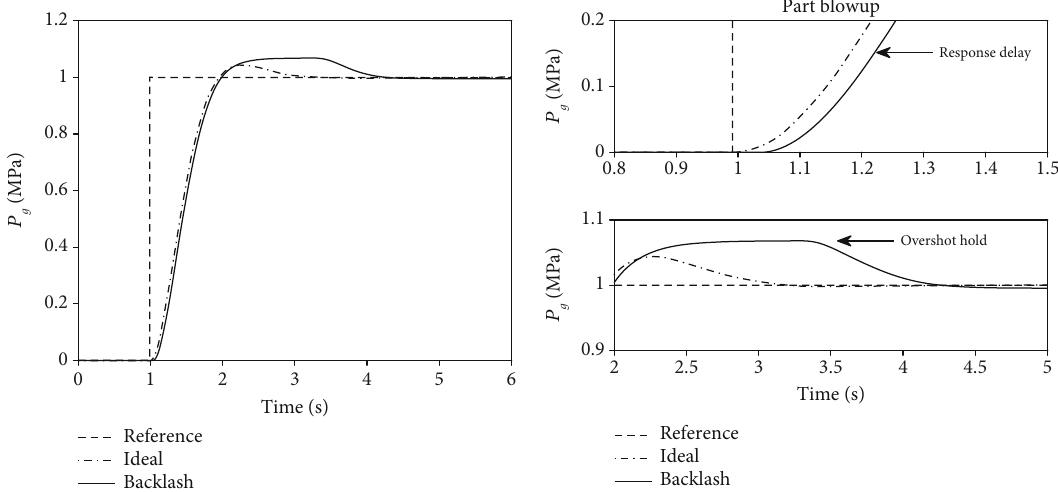
Figure 6: E ff ects of backlash on the pressure control